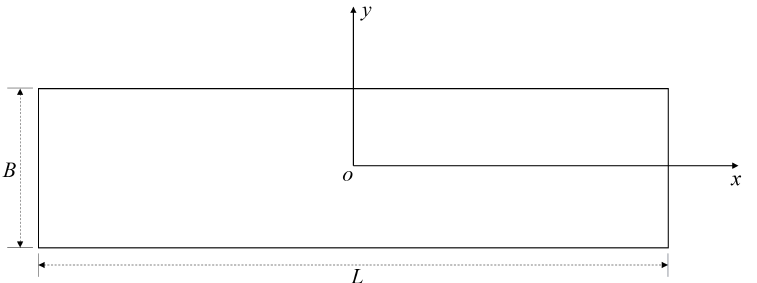
Figure 5. Parameters of water plane